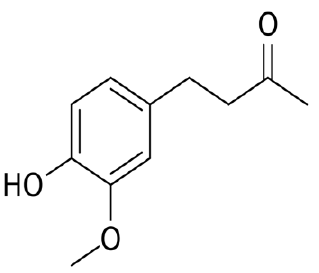
Figure 1. Chemical structure of Zingerone [4-(3-methoxy-4-hydroxyphenyl)-butan-2-one].